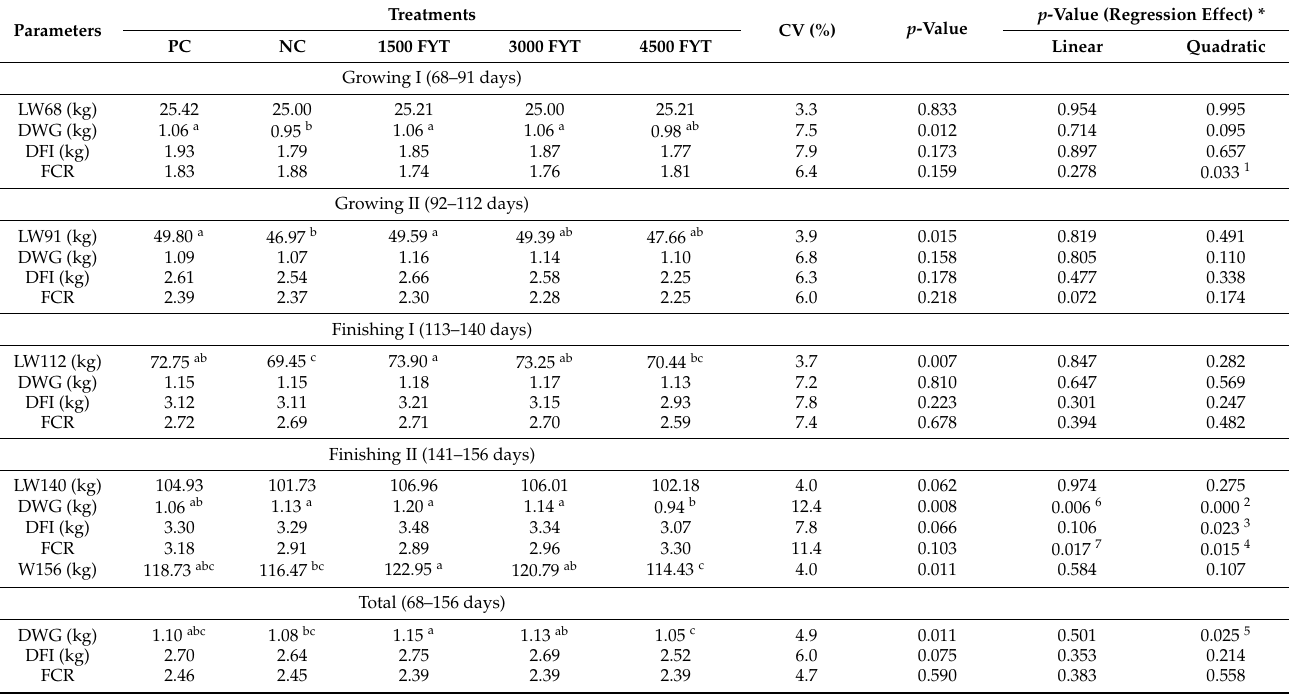
Table 2. Mean live weight (LW), daily weight gain (DWG), daily feed intake (DFI), and feed conversion rate (FCR) during each phase and total evaluation period according to the experimental treatment.